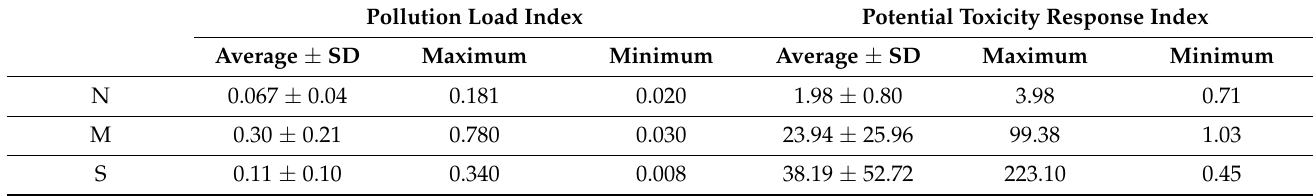
Table 6. Pollution Load Index and the Potential Toxicity Response Index for the North, Middle and South locations in the study